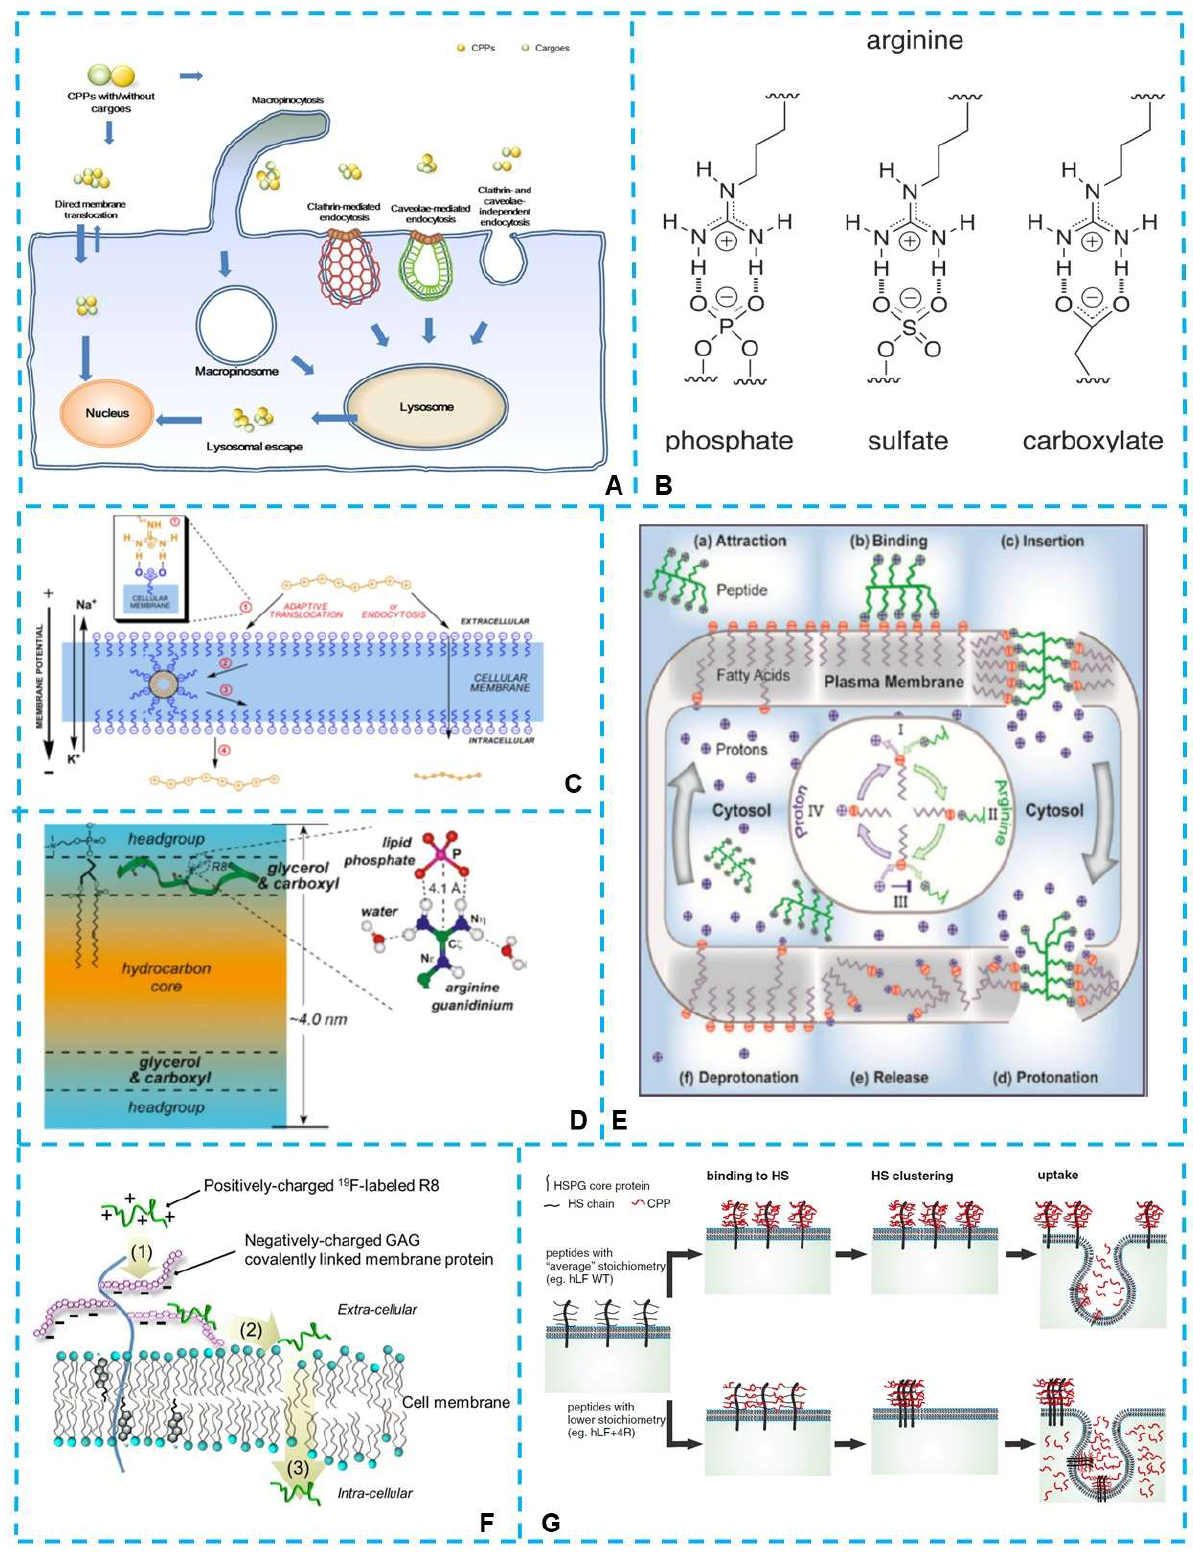
Figure 1. ( A ) Different cellular entry routes for either cell-penetrating peptides (CPPs) alone or CPP/cargo complexes. Direct membrane translocation and endocytosis were two major routes which had been proposed [33]. ( B ) Possible divalent hydrogen bond formation by the side-chain guanidino moiety of arginine with phosphate, sulfate, and carboxylate groups [37]. ( C ) Mechanisms